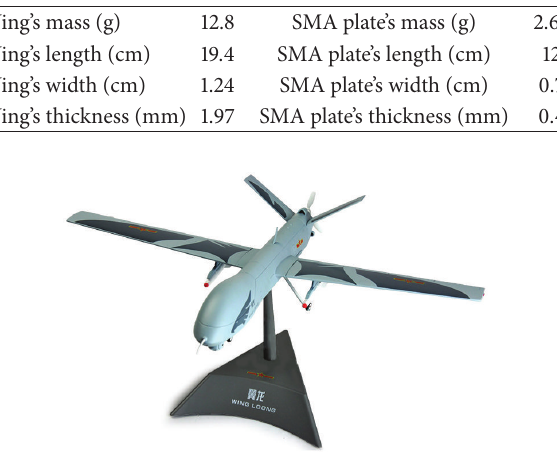
Table 1: Model’s parameters.